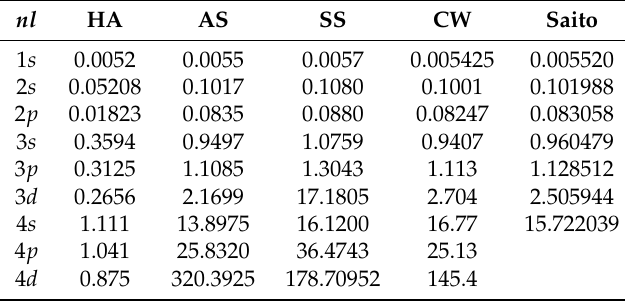
Table 4. Comparing the values of AS, SS, and CW atomic structure codes with values calculated by Saito 2009 [13] in a.u.